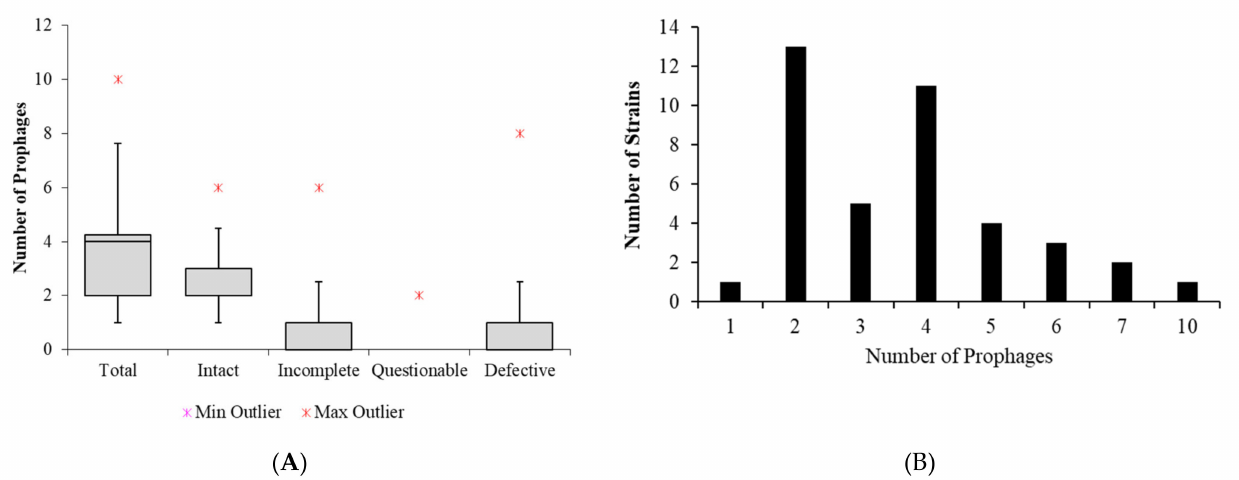
Figure 1. ( A ) Box plot showing the total, intact, incomplete, questionable, and defective (incomplete + questionable) prophages of Klebsiella pneumoniae . ( B ) Bars graph showing the distribution of total prophages (intact, incomplete, and questionable) in K. pneumoniae